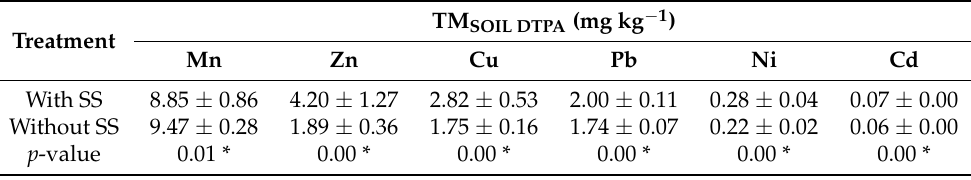
Table 5. Mean ± standard deviation of the DTPA extractable concentration of Mn, Zn, Cu, Pb, Ni and Cd in soil, depending on whether they have received SS or not, together with their p -value.